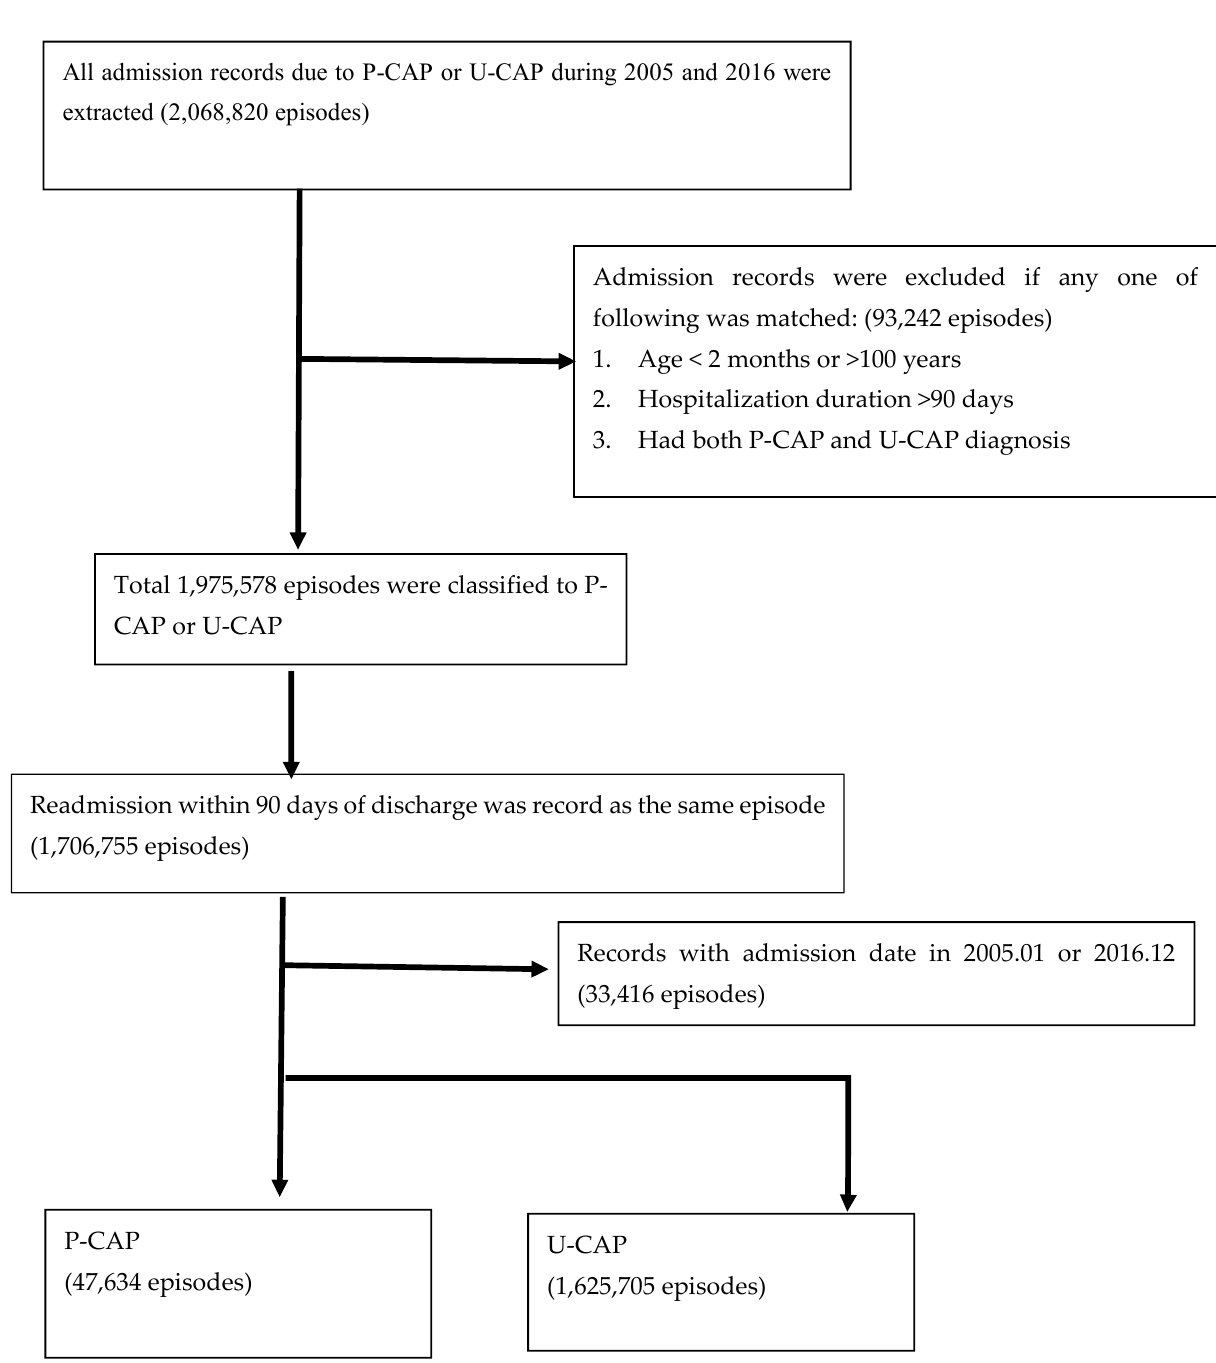
Figure 1. Analytic flowchart of pneumococcal and unspecific community-acquired pneumonia hospitalization from National Health Insurance Database during 2005 and 2016.